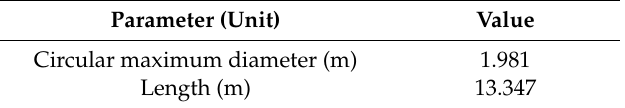
Table 4. Geometrical reference data for the fuselage (geometry information from